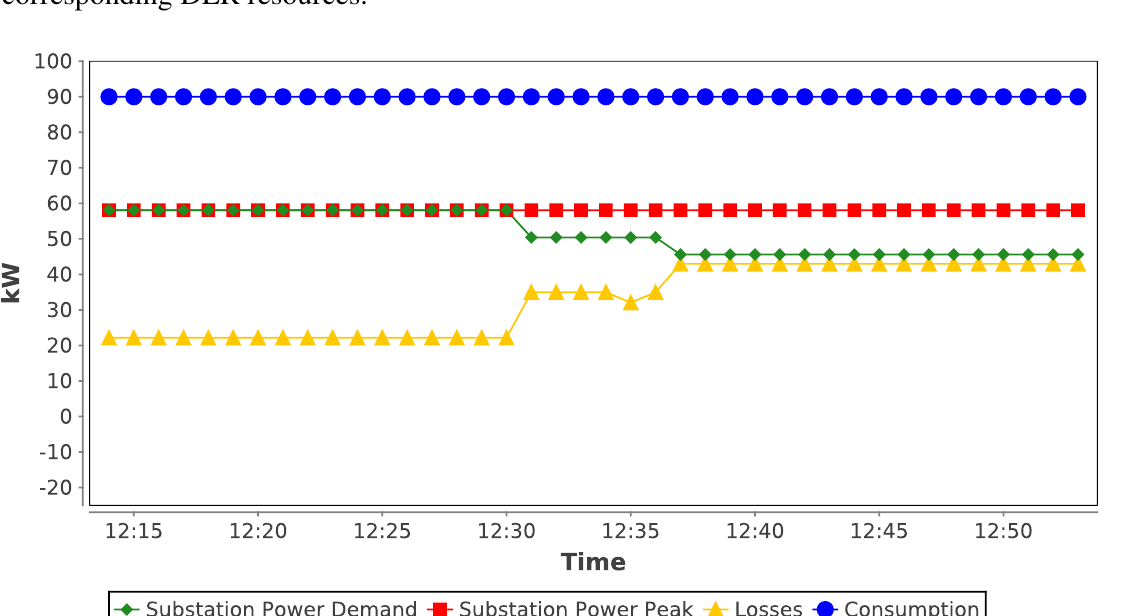
Measurements at the Substation when DER agents connect and enable the corresponding DER